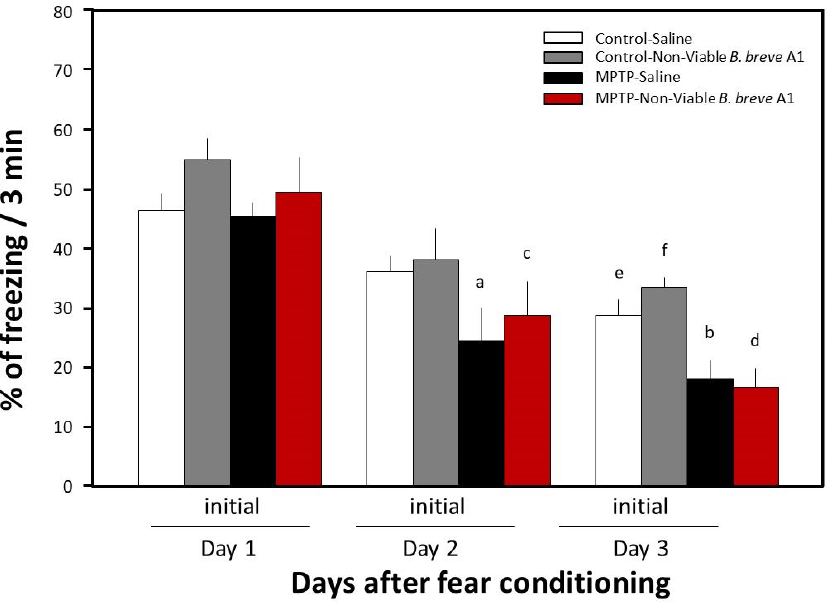
Figure 3. Effects of nonviable B. breve A1 on contextual fear extinction in mice. Mice were given oral administration of nonviable B. breve A1 at a volume of 0.2 mL (1 × 10 9 cfu organisms suspended in saline) or saline for 4 days from 3 days before the conditioning day. Data are expressed as the mean ± SEM; n = 5. a p < 0.05 and b p < 0.01 vs. MPTP + Saline on Day 1, c p < 0.05 and d p < 0.01 vs. MPTP + nonviable B. breve A1 on Day 1, e p < 0.05 vs. Control + Saline on Day 1 and f p < 0.05 vs. Control + nonviable B. breve A1 on Day 1.